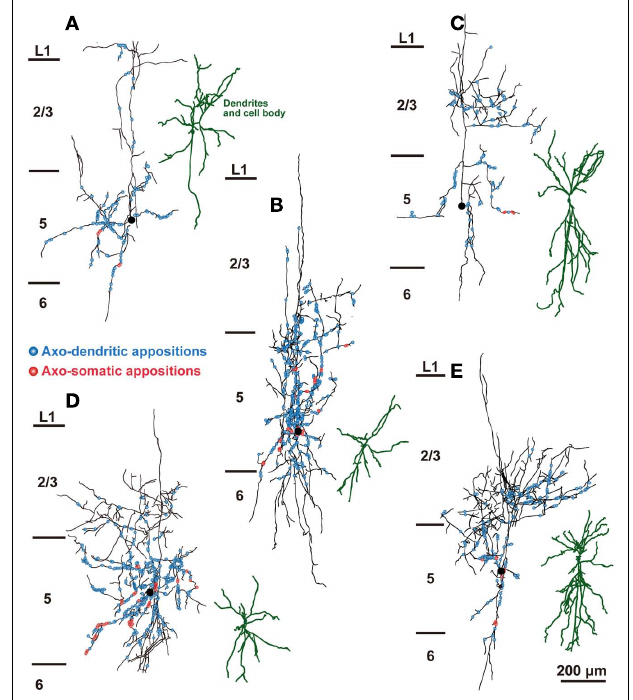
FIGURE 5 |The distribution of axon boutons of SOM neurons in close appositions to CSNs. Axons and dendrites of L5 SOM neurons were reconstructed and projected to the frontal plane. Black lines and filled circles indicate the axons and cell bodies of SOM neurons, respectively. Blue and red circles indicate the axodendritic and axosomatic appositions, respectively.The dendrites were reconstructed dark green. Note that